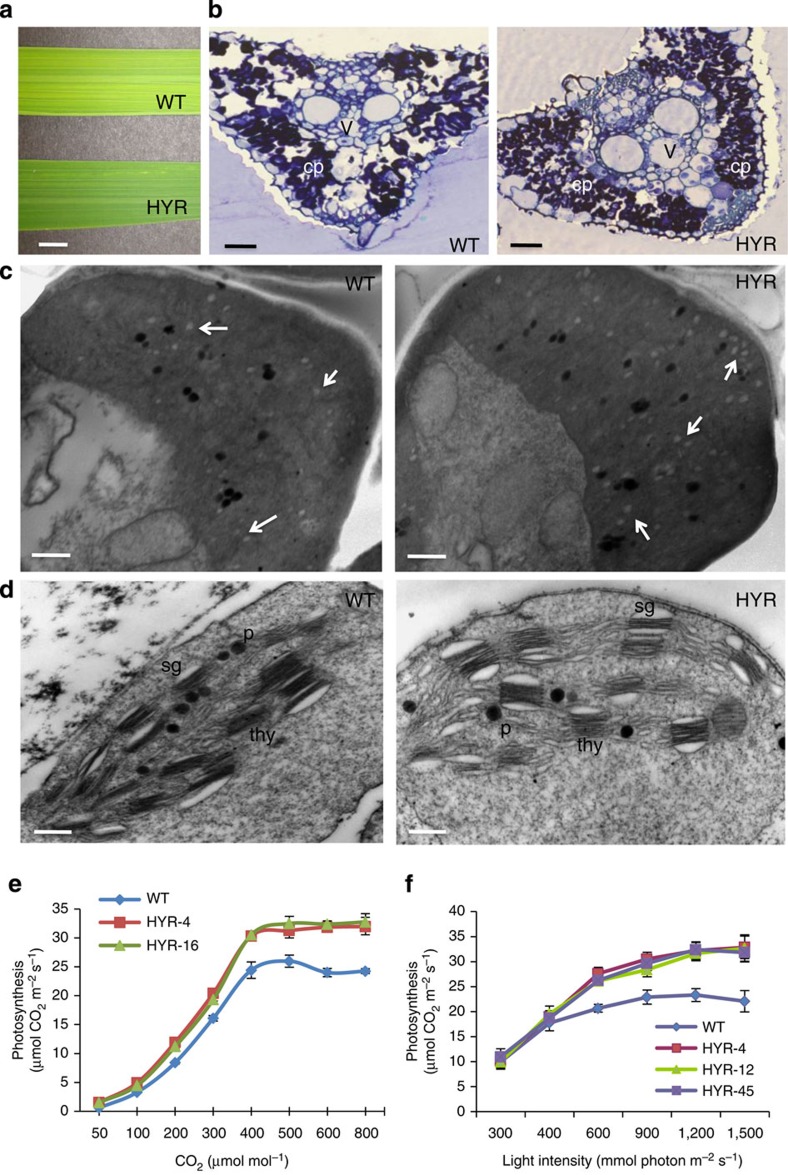
Morpho-physiological features of rice HYR lines showing enhanced photosynthesis parameters.(a) Leaf blade phenotype of WT (upper) and a HYR line showing the darker-green leaf surface in HYR plants; scale bar, 1 cm. (b) Increased number of dark-staining chloroplasts (labelled ‘cp’) in HYR compared with WT, images taken by confocal microscopy of leaf sections stained with 1% Toluidine blue and photographed ( × 40) under identical settings, vascular bundles labelled ‘v’; scale bar, 50 μm. (c) Flag leaf parenchyma cells of WT and HYR plants visualized by transmission electron microscopy showing increased number of white starch granules (arrows) in HYR cells; scale bar, 4 μm. (d) Transmission electron micrographs of WT and HYR leaves, showing thylakoid ultrastructure of mesophyll chloroplasts after drought treatment; labels are sg, starch grain; p, plastoglobulus; thy, thylakoid; scale bar, 250 nm. (e) Assimilation rate as a function of increasing CO2 concentration at saturated light intensity of 1,500 mmol m−2 s−1 in WT and HYR lines, measured by portable photosynthesis system LI-6400XT, values are means±s.e. (n=6). (f) Assimilation rate as a function of increasing light intensity at CO2 concentration of 370 μmol mol−1 in WT and HYR lines measured by LI-6400XT system, values are means±s.e. (n=6).